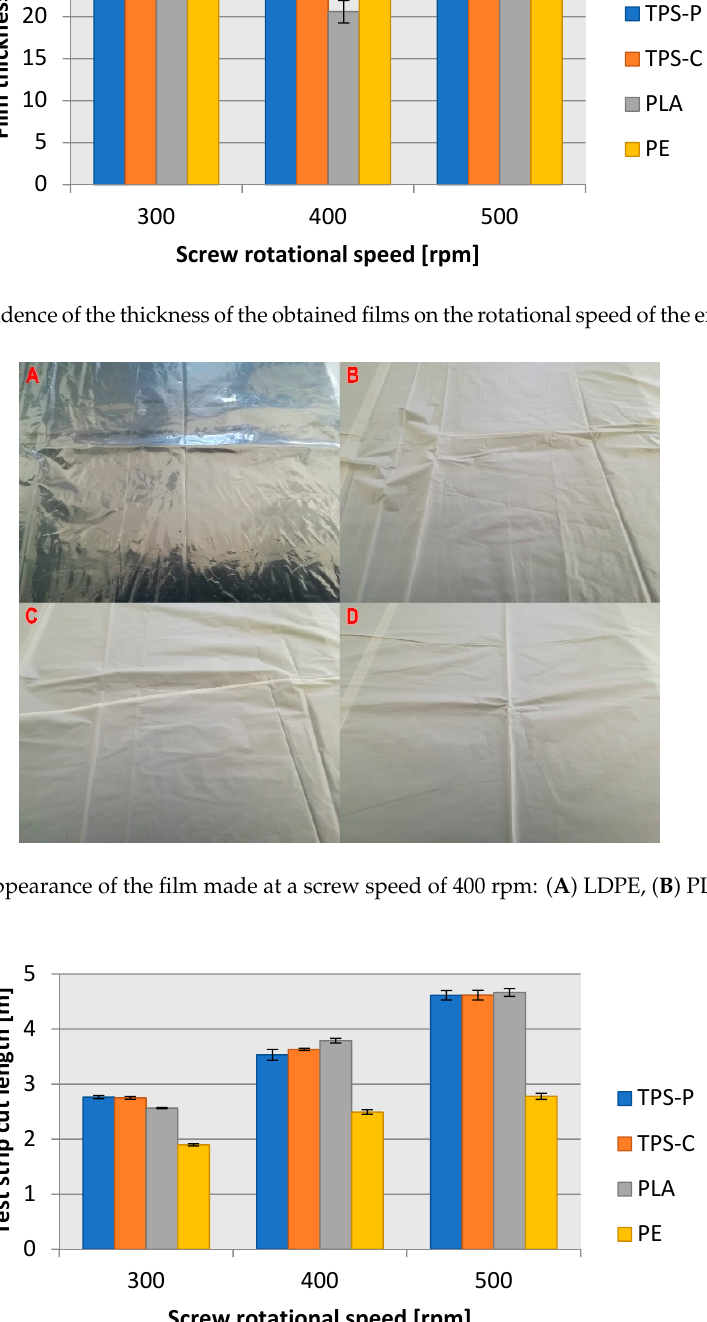
Figure 8. Dependence of the length of measuring sections of the obtained films on the rotational speed of the extruder screw.